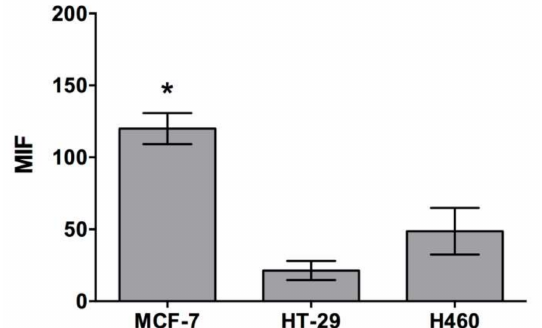
Figure 5. Phosphatidylserine (PS) may play a role in the internalization mechanism of CIGB-552 favoring transduction. To evaluate PS levels, Annexin V was used as a marker and further evaluated its levels by flow cytometry. Values obtained showed that MCF-7 possess the highest expression of PS (* Mann-Whitney U Test, p <